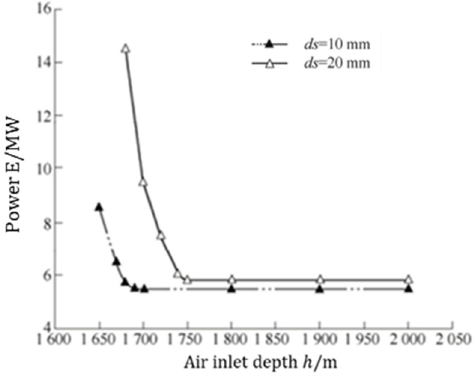
Figure 3. Net power diagram required for conveying different air inlet depths and different ore particle diameters (10 mm and 20 mm).